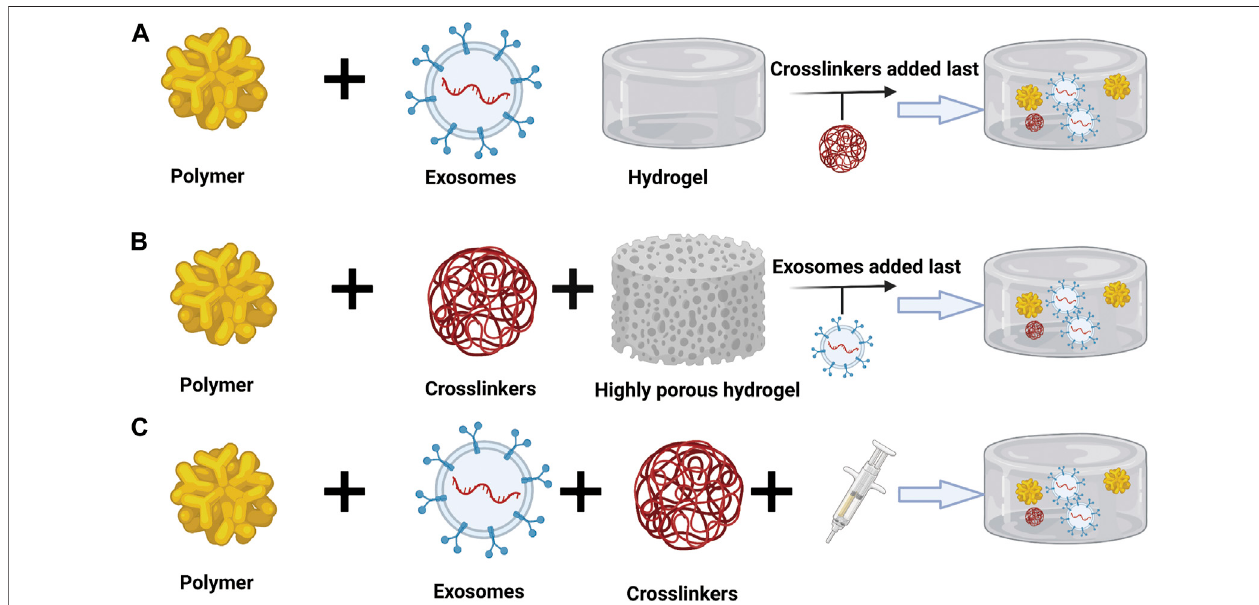
FIGURE 6 | Approaches to encapsulate exosomes in hydrogels: (A) Combining the exosomes with polymers followed by the addition of crosslinkers to induce gelation. (B) Physical incorporation of the hydrogels, or the “ breathing ” technique. (C) Mixing of the exosomes with both the polymers in solution and crosslinkers simultaneously (Khayambashi et al., 2021). Copyright 2021, MDPI, Basel,